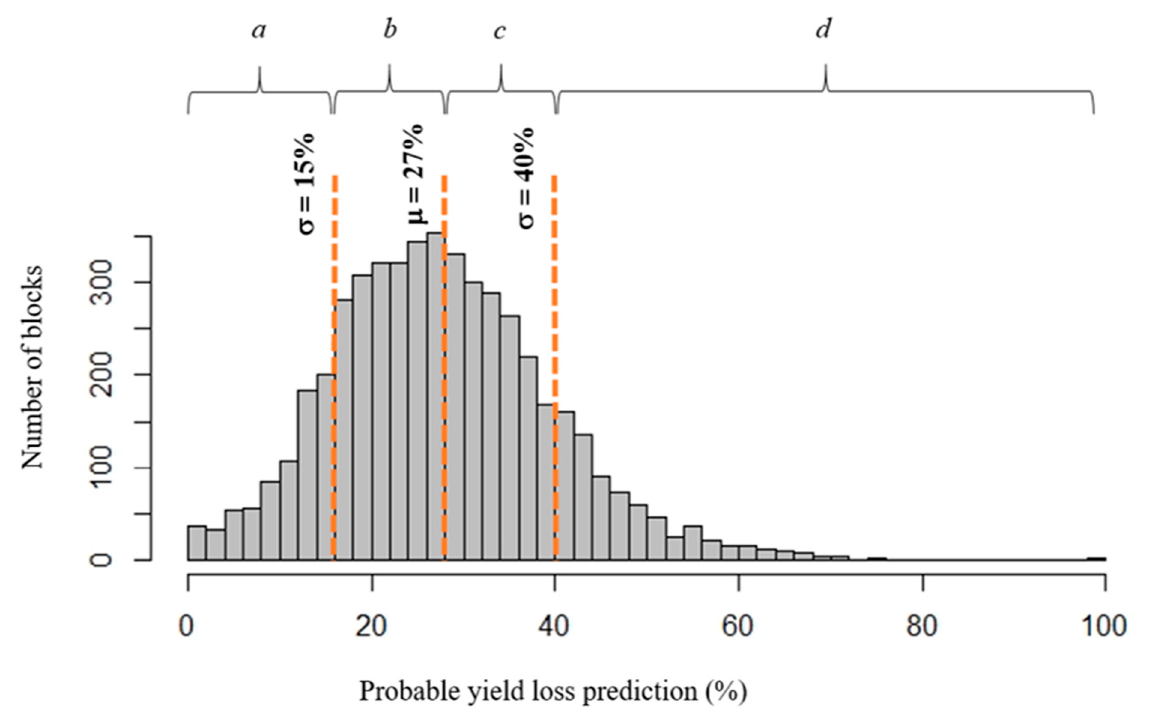
Figure 9. Histogram of the prediction of yield loss for the 4978 vineyard blocks. The vertical orange dashed lines highlight the mean ( µ ) and the thresholds corresponding to µ ± σ ( σ standing for the standard deviation). The 4 classes from a to d defined on these thresholds were linked to the degree of impact of the heatwave, with a being the class with the lowest impact and d the class with the highest impact.